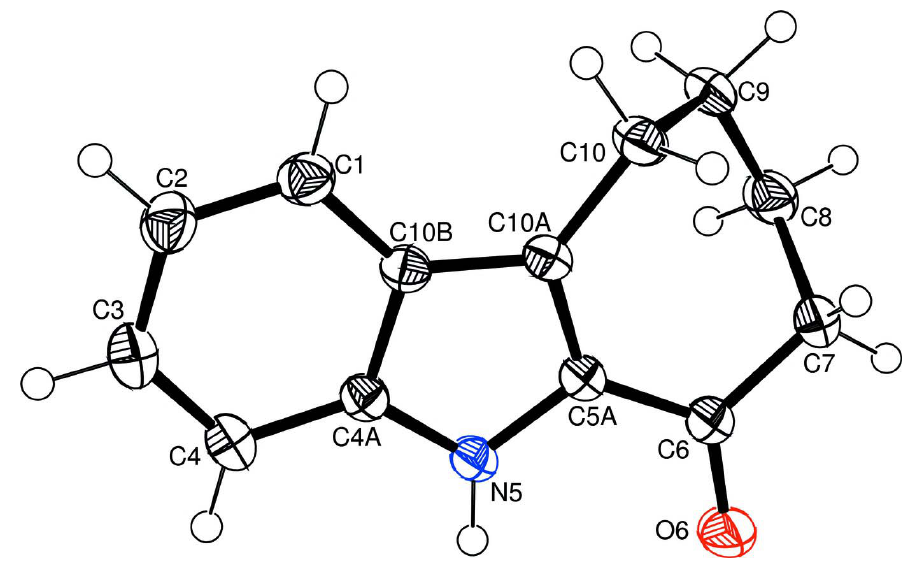
Figure 1 The molecular structure of the title compound, showing the atom-numbering scheme and displacement ellipsoids drawn at the 50% probability level. Hydrogen atoms are represented by spheres of arbitrary